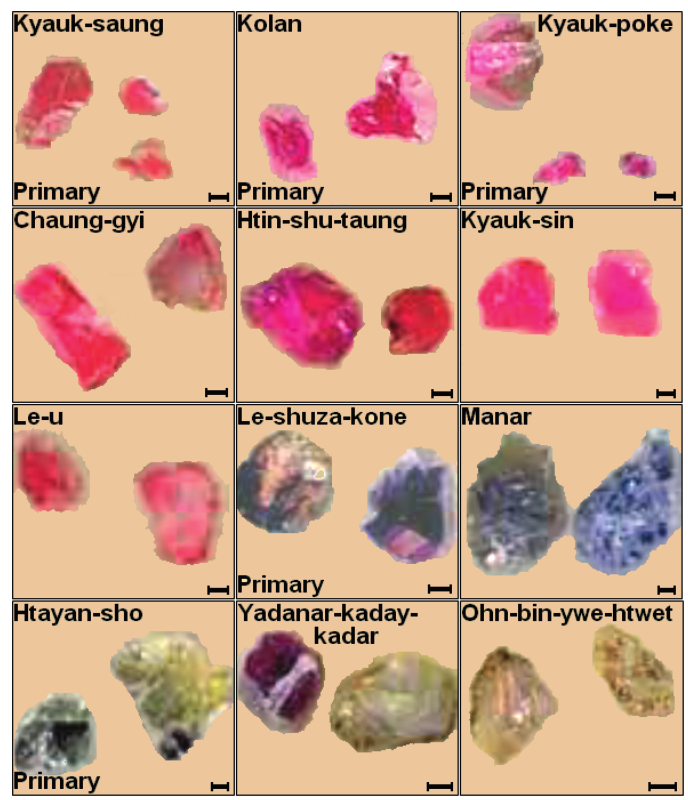
Figure 1. Color ranges of mounted samples. The scale bars represent 1